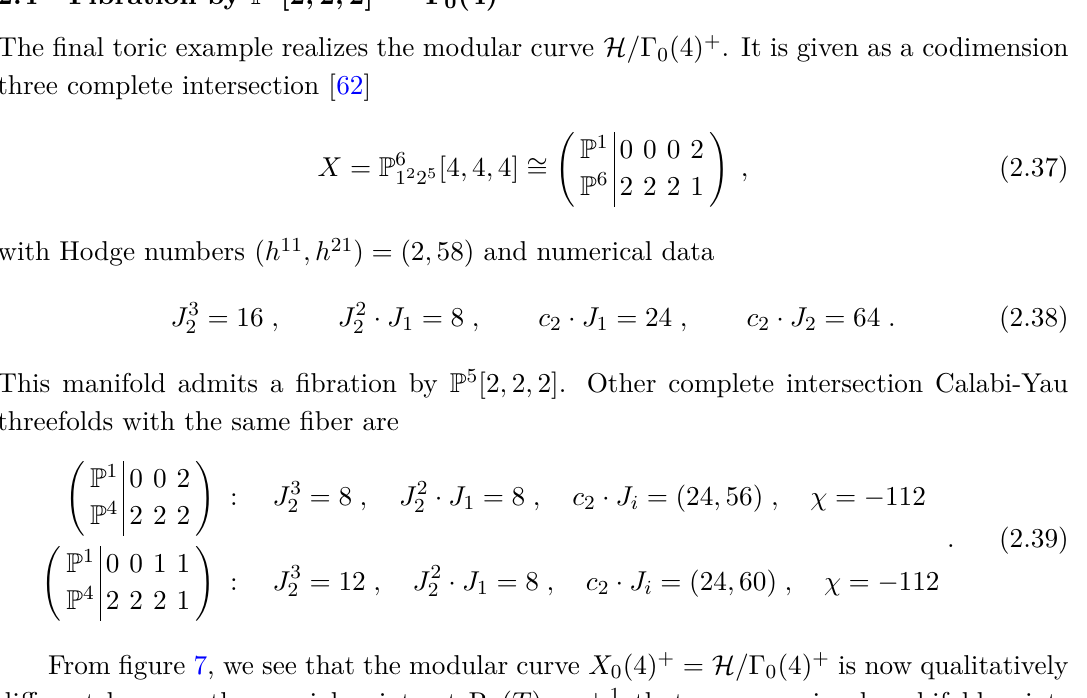
Figure 7 . Left: a fundamental domain X 0 (4) for Γ 0 (4) that is symmetric under the Fricke involu- tion F . Right: a fundamental domain for Γ 4 the following: p = 1 / 2 is a cusp and p 9 third cusp of X (4) 0